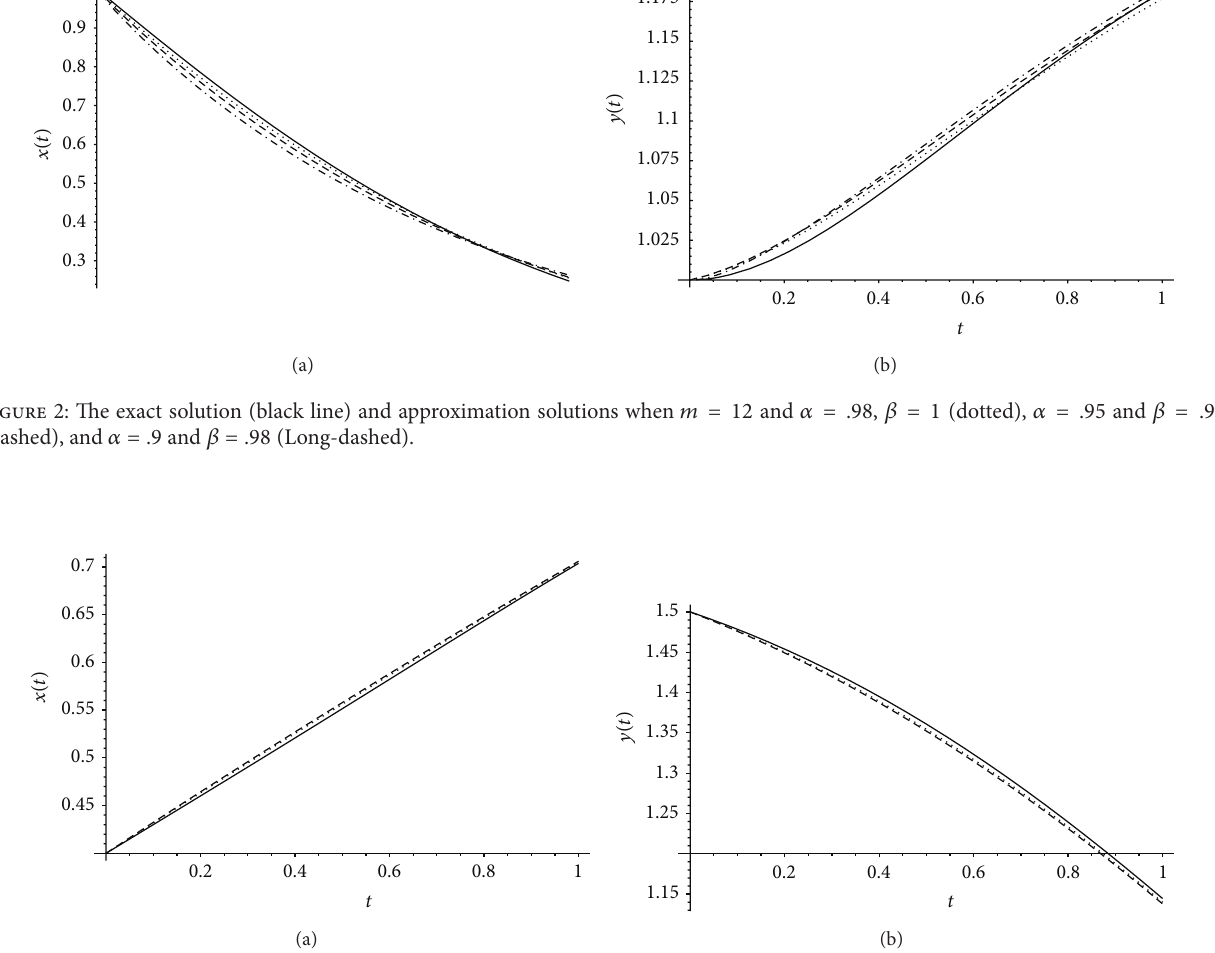
Figure 3: The exact solution (black line) and approximation solutions when 𝛼 = 1 , 𝛽 = 1 , and 𝑚 = 6 (dotted) and 𝑚 = 4 (dashed).